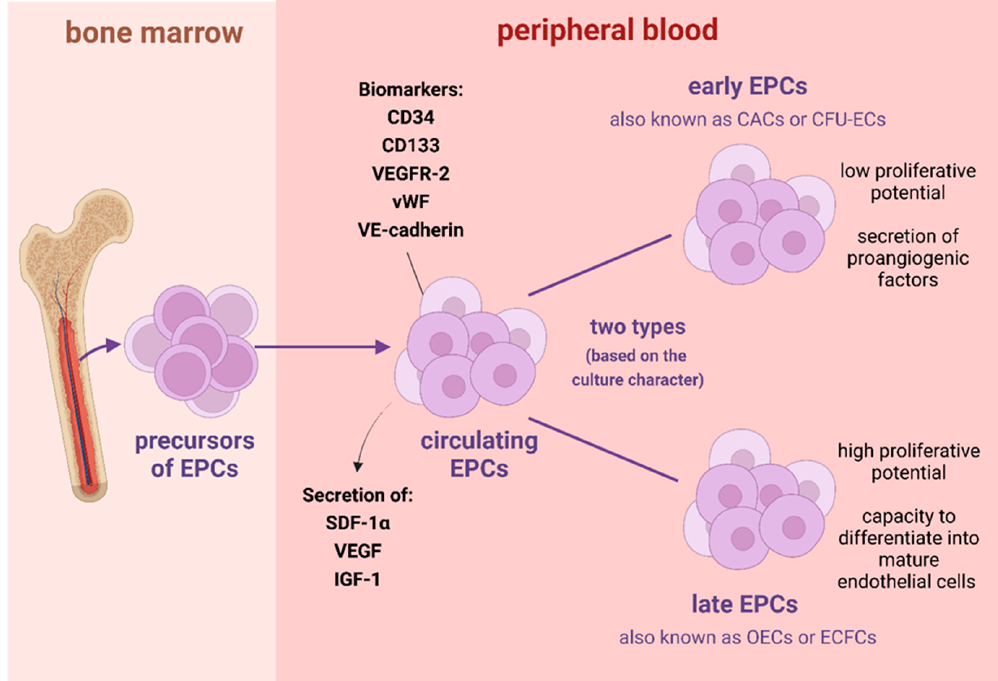
Figure 1. Characteristics of endothelial progenitor cells. Abbreviations: CACs–circulatory angio- genic cells; CFU-ECs–colony-forming unit endothelial cells; ECFCs–endothelial colony-forming cells; EPCs–endothelial progenitor cells; IGF-1–insulin-like growth factor 1; OECs–outgrowth endo- thelial cells; SDF-1 α –stromal cell-derived factor-1 α ; VE-cadherin–vascular endothelial cadherin; VEGF–vascular endothelial growth factor; VEGFR-2–vascular endothelial growth factor receptor-2; vWF–von Willebrand factor. Image created with biorender.com; accessed on 22 September 2022.